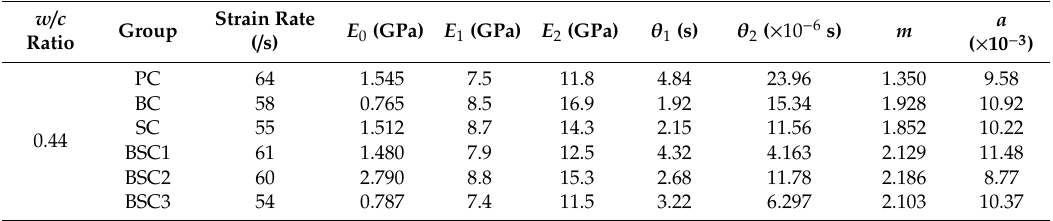
Figure 20. Microscopic appearance of mortar: ( a ) w/c ratio: 0.68; ( b ) w/c ratio: 0.54; ( c ) w/c ratio: 0.44.